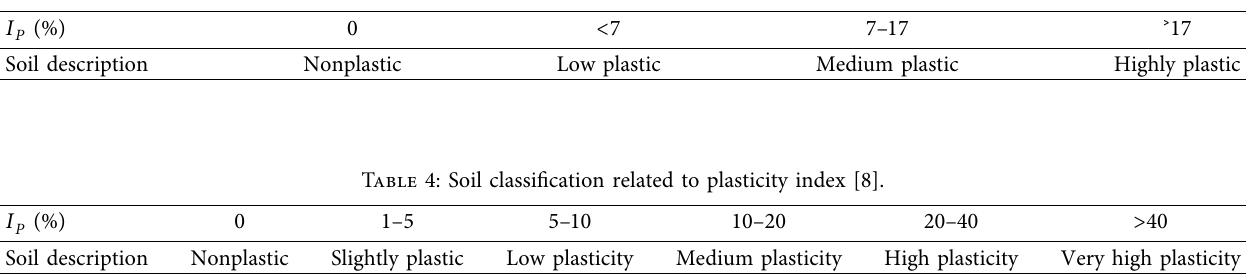
Table 3: Soil classification related to plasticity index [9, 10].